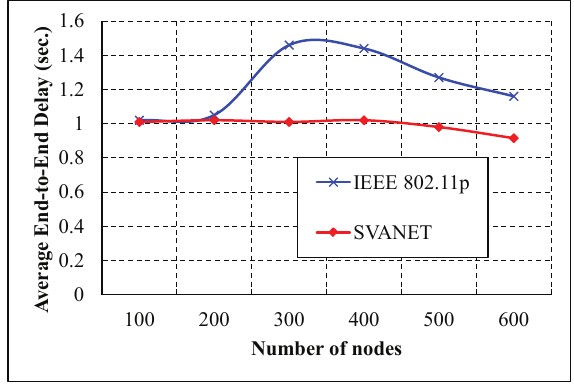
Figure 18. Average end-to-end delays in the highway with six lanes.